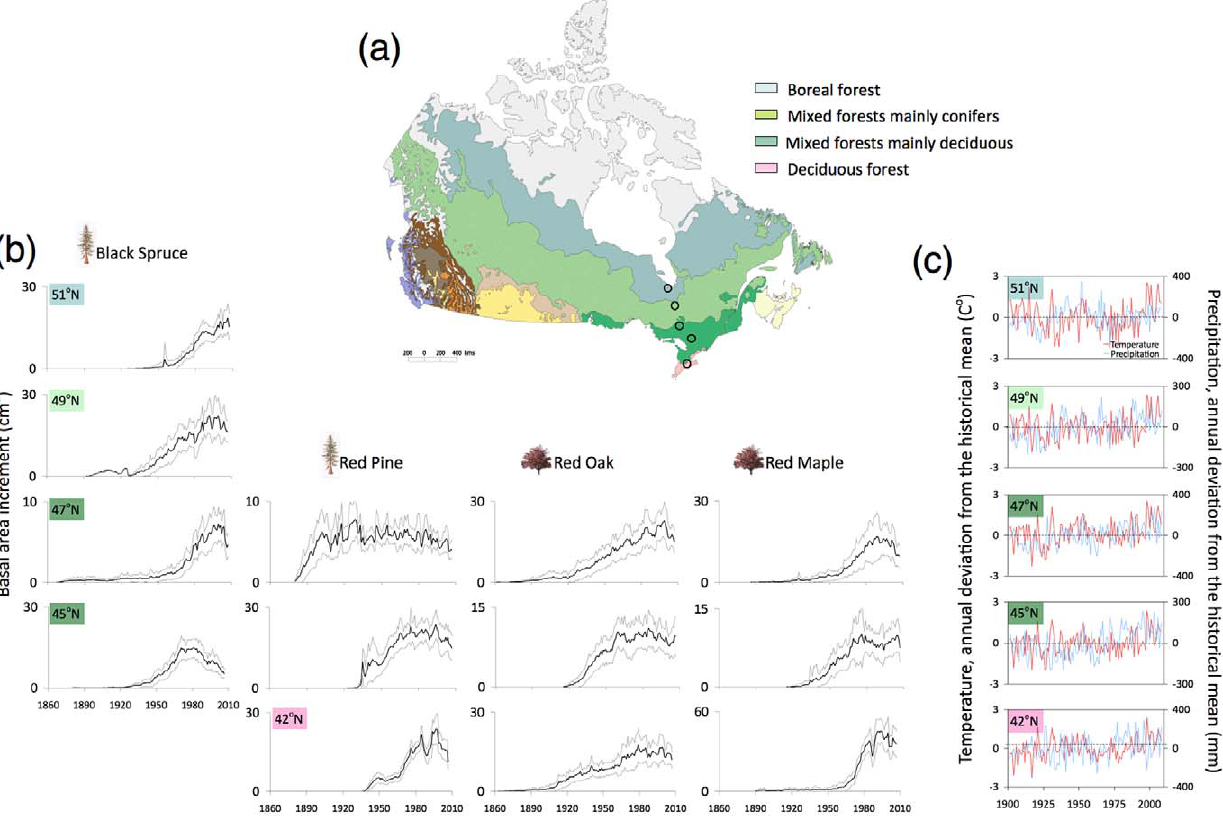
Figure 1. ( a ) Vegetation map of Canada and sampling sites (black circles); ( b ) average annual basal area increment (BAI) for black spruce - Picea mariana (Mill.) B. S. P.; red pine - Pinus resinosa Ait.; red oak - Quercus rubra L. and red maple - Acer rubrum L.; ( c ) past century annual temperature and precipitation deviations from the historical average mean (since 1900) for each sampling site. Species were sampled according to their range. Gray lines represent one standard deviation.